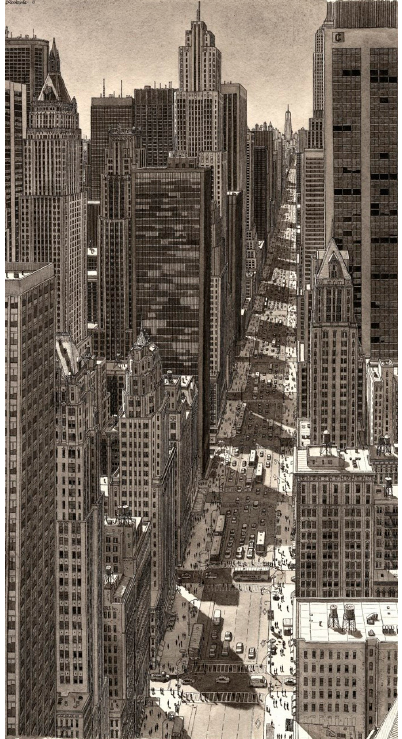
Figure 6. New York City drawing from memory by Stefan Bleekrode, monoculture universal template of New York.